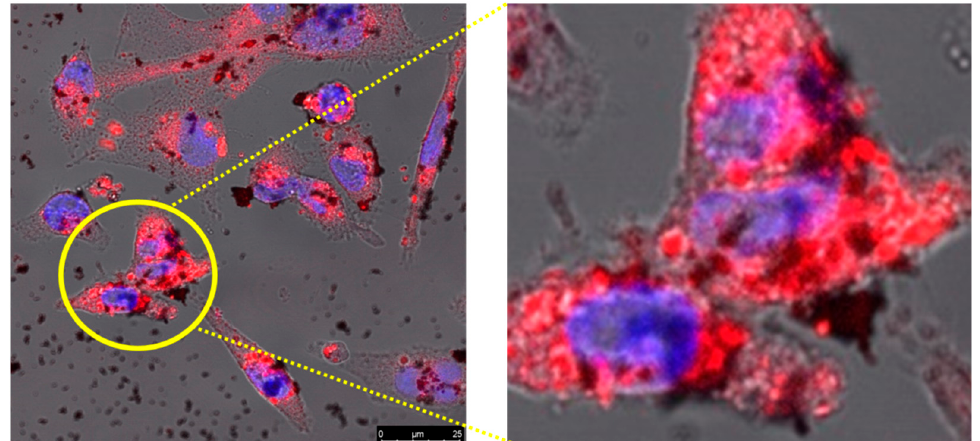
Figure 10. Intracellular release of DOX from T GNC-DOX. Red fluorescence indicates DOX (scale: 25 µm).